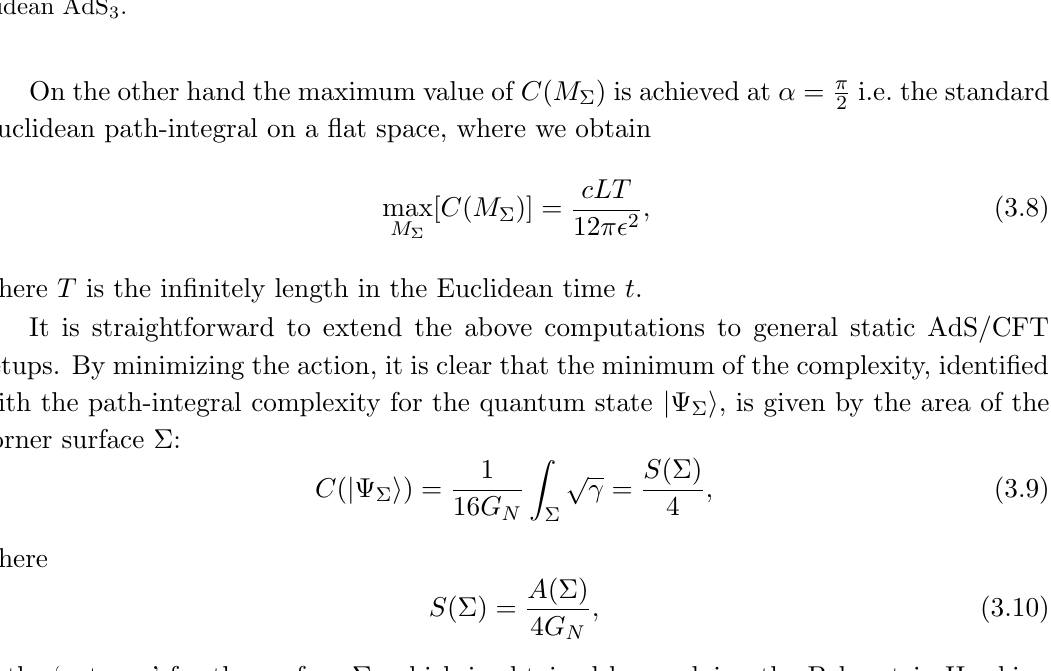
Figure 5 . The setup of holographic calculation of path-integral complexity in a Poincare Eu- clidean AdS 3